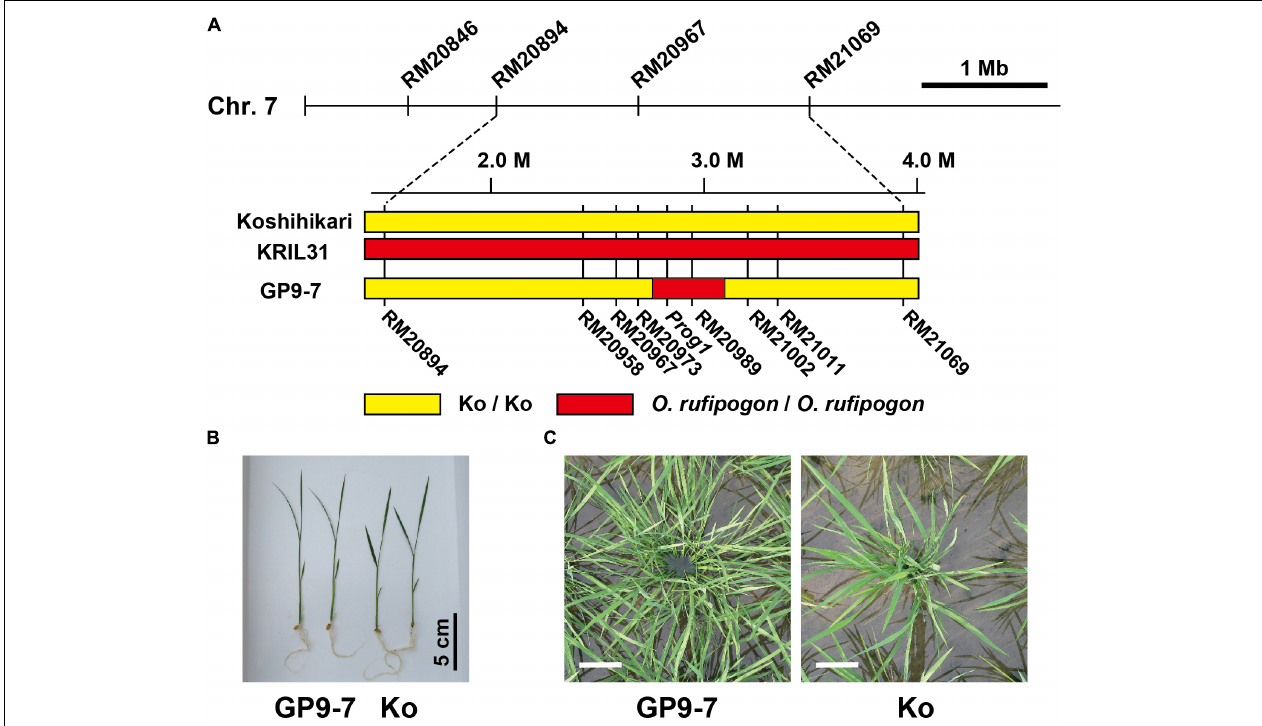
FIGURE 1 | Basic properties of GP9-7. (A) A comparative diagram showing the genotyping results of GP9-7, KRIL31, and Koshihikari. The yellow zones indicate the segments derived from Koshihikari and the red zones represent the segments derived from Oryza rufipogon ( O. rufipogon ). (B,C) Typical plant shapes of the rice plants are used in this study. The photograph (B) shows typical nursling seedlings of Koshihikari and GP9-7 at 10 days after sowing. The photographs (C) indicate typical plant shapes in paddy fields taken from directly above the plants at 33 days after planting (DAP). Scale bars: 10 cm.